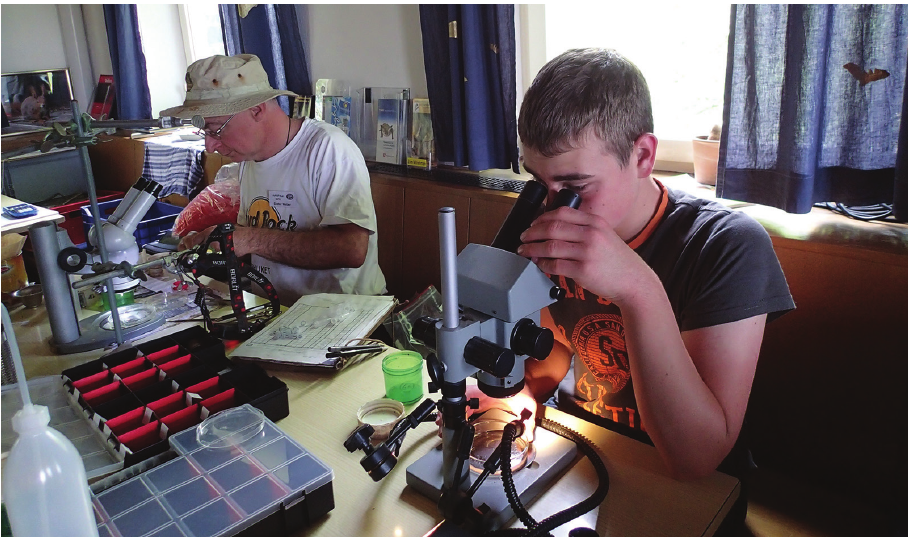
Figure 2. Determination of cave animals in the “lab” during the JuHöFoLa (Photo: Otto